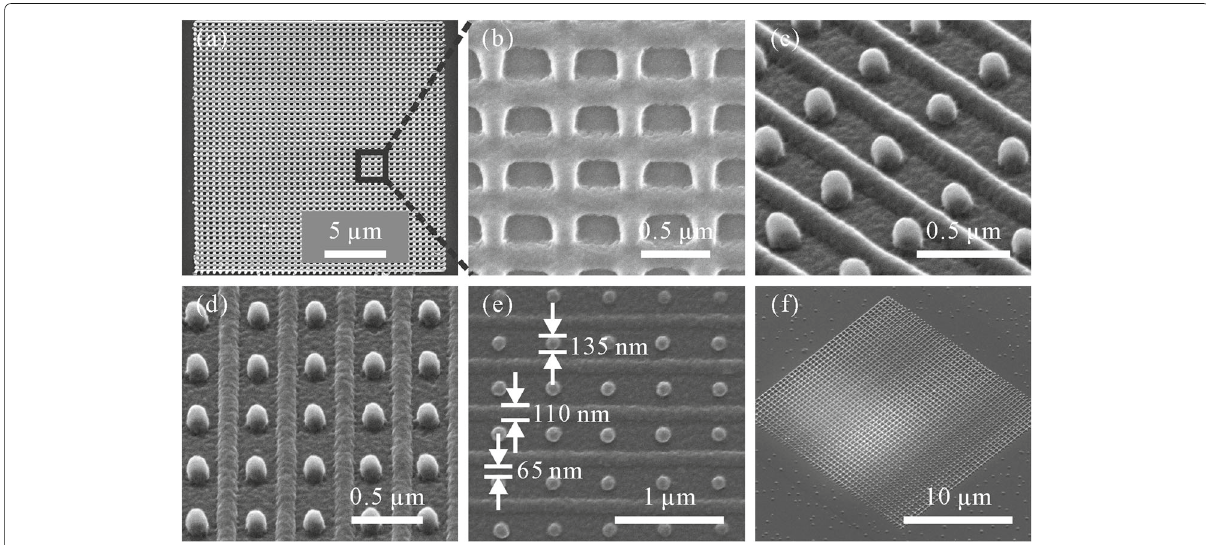
Fig. 9 SEM images of 2PP fabricated periodic structure with PD = 200nm. Material: E-shell 300. Intensity used for the fabrication of grating lines: I = 0.83kW/ μ m 2 ; pillars: I = 0.6kW/ μ m 2 . The relative laser focus distance for fabrication of grating lines and pillars is 300nm. a – b